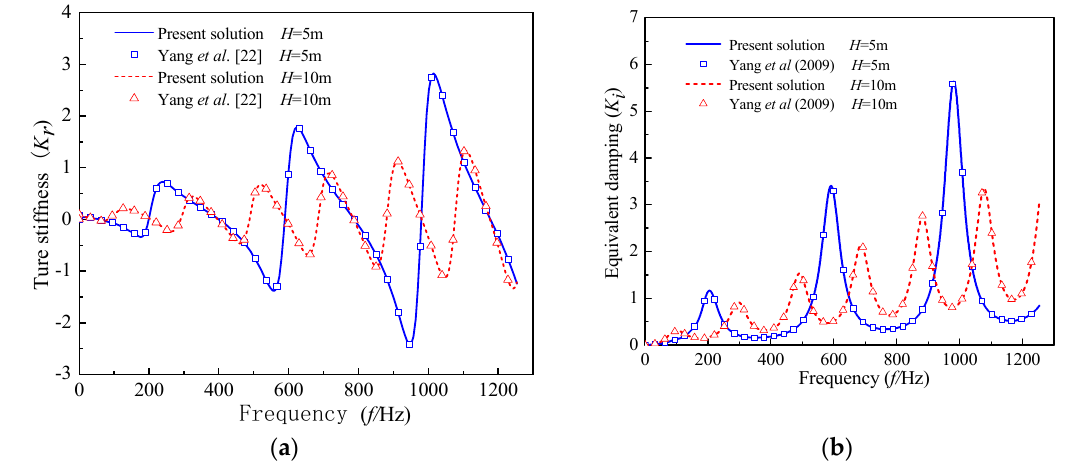
→ 0 and ν p → 0) and the results of j